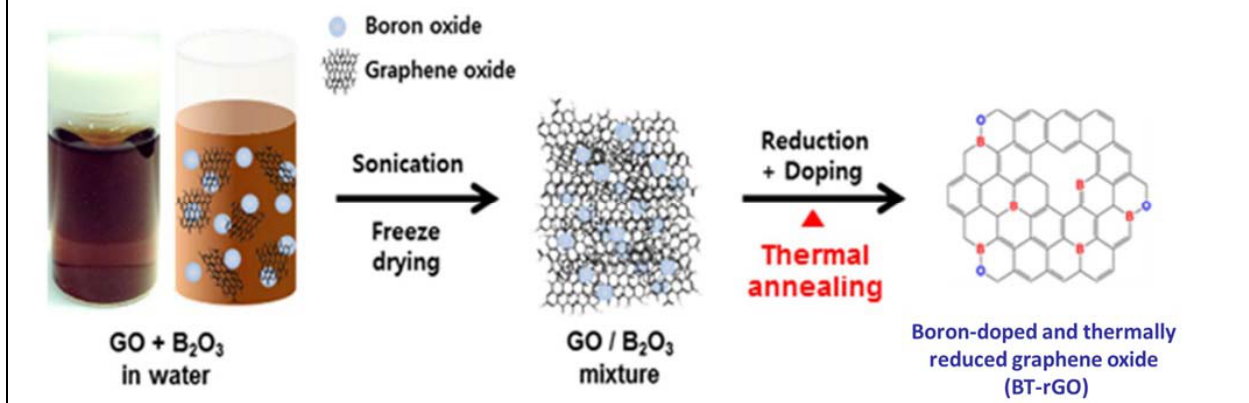
Figure 4. Synthesis of B-GNS using the thermal annealing method. Adapted from Yeom et al. [94], with permission from Springer. Copyright (2015).